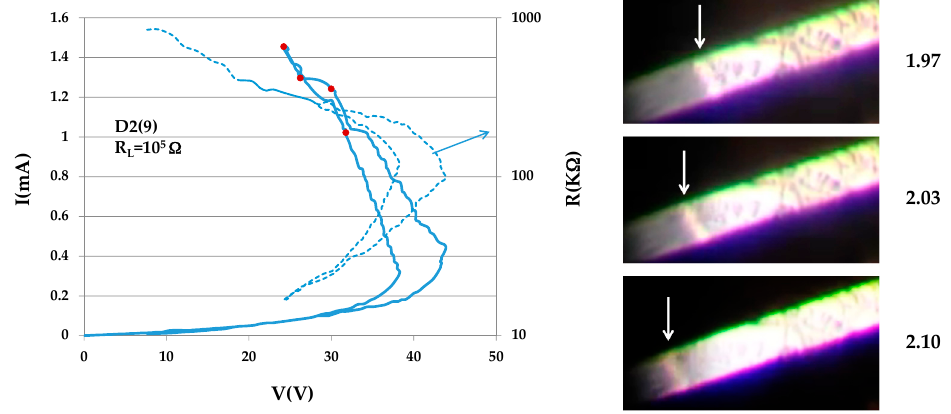
Figure 6. I–V characteristic of sample D2(9) and three images of a portion of the sample snipped 0.6 s apart.